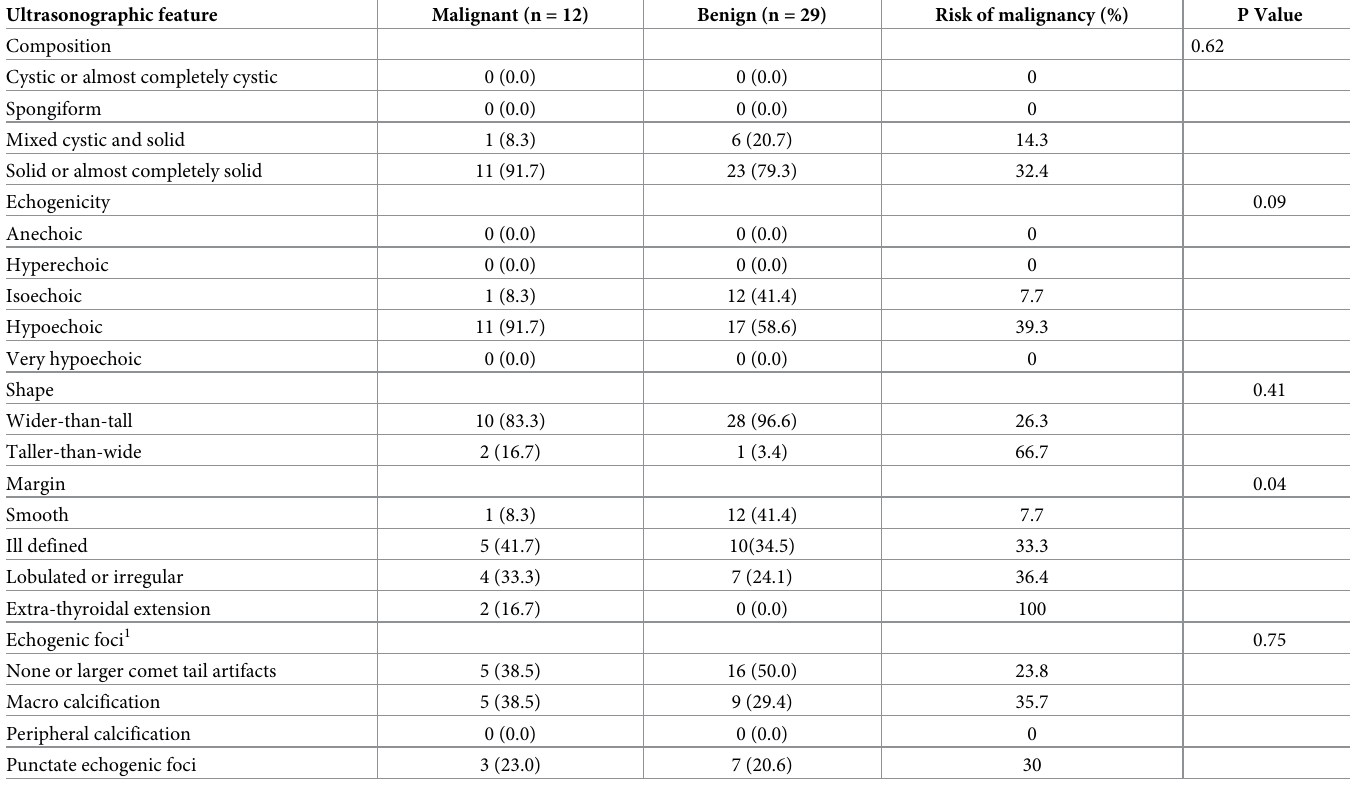
Table 1. Frequency and risk of malignancy for cytological indeterminate thyroid nodules based on ultrasonographic features.